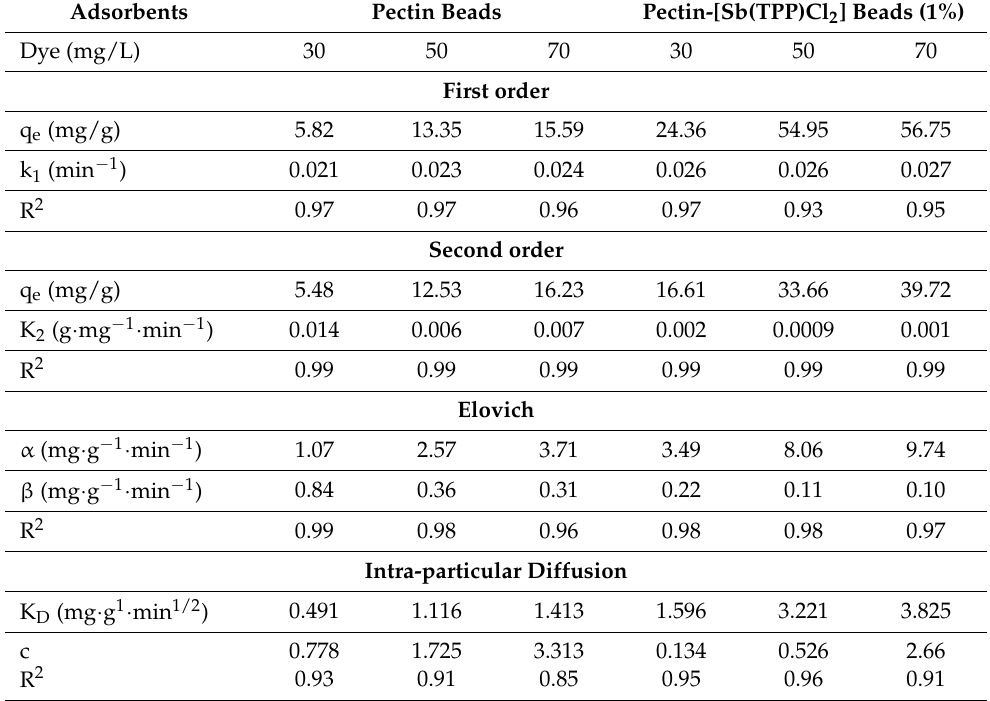
Table 3. A summary of the kinetic data determined for pectin beads and pectin-[Sb(TPP)Cl 2 ] beads (1%).